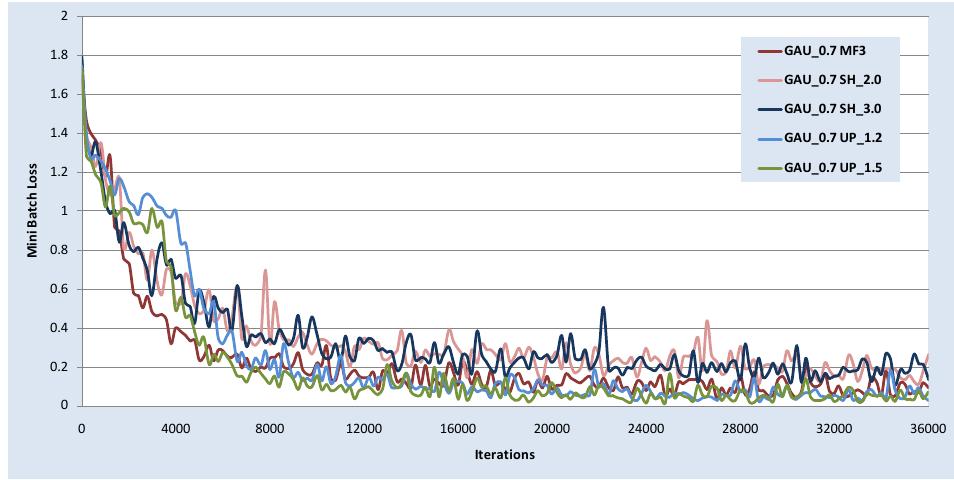
Figure 11. Mini-batch loss analysis.